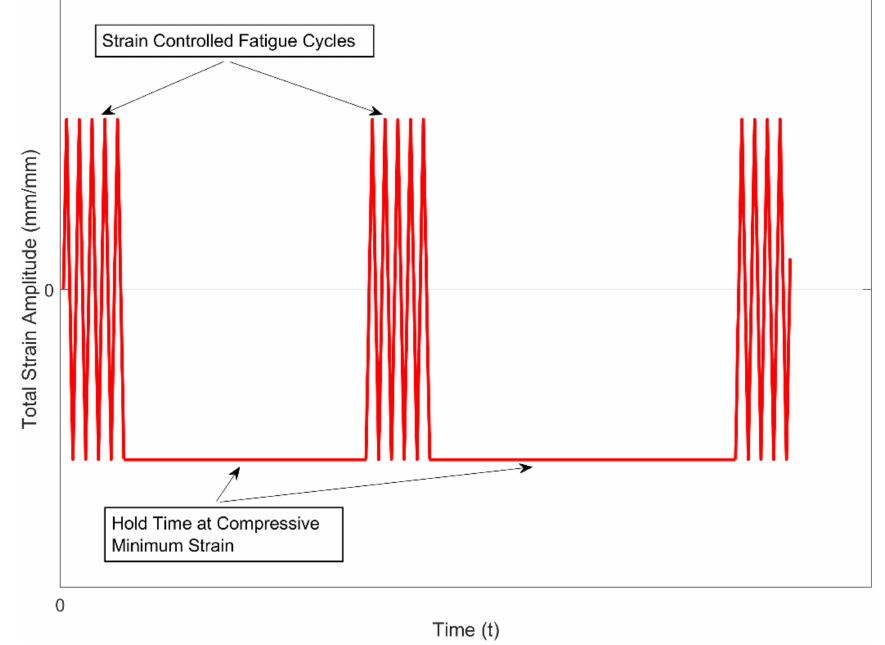
Figure 5. Test schematic for the combined fatigue + hold time tests. Table 2. Summary of the test plan. RT, room